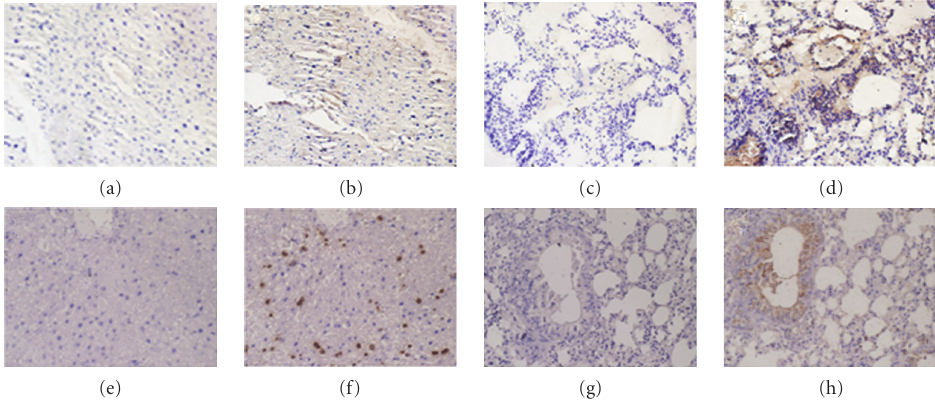
Figure 5: IL-33 immunostaining in mouse liver (a), (b), (e), (f) and lung (c), (d), (g), (h) tissues using the rabbit anti-IL-33 antibodies (1:1,000) under a microscope ( × 400). Immunohistochemical analysis was performed in formalin-fixed, para ffi n-embedded livers and lungs from normal mice and hydrodynamics-based gene injected mice after 24 hours ( n = 4). Staining of IL-33 in livers and lungs from normal mice (b), (d) and hydrodynamics-injected mice (f), (h). Antibodies showed nuclear or cytoplasmic staining. Furthermore, there was a significant increase of IL-33 expression in hydrodynamics-injected mice (f), (h) compared with normal mice (b), (d). Control IgG showed no stain (a), (c), (e),